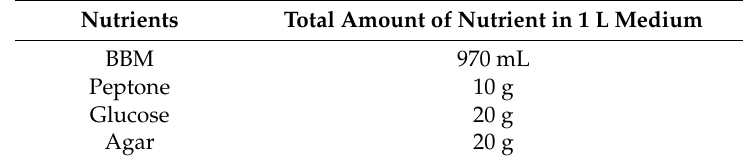
Table A4. Trebouxia medium (TM, Ahmadjian, 1987).